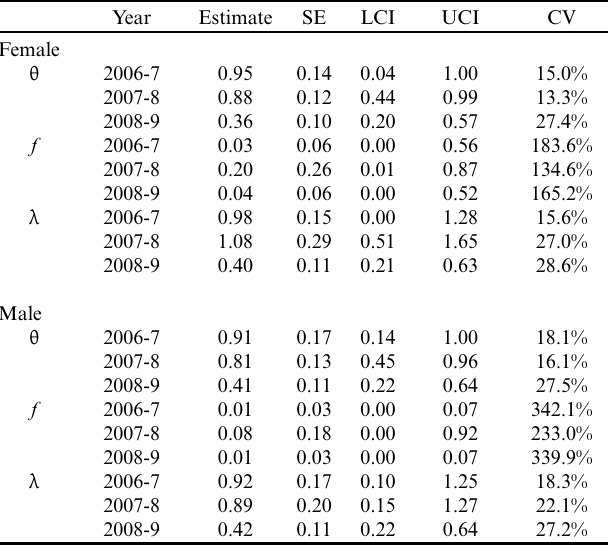
Table 4 . Model averaged demographic parameter estimates for males and females for the Koeye grizzy bear ( Ursus arctos horribilis ) DNA mark-recapture analysis 2006-2009. Estimates of apparent survival ( θ ), rates of addition ( f ), and population rate of change ( λ ) are displayed with lower (LCI) and upper (UCI) 95% confidence limits listed for each. Models used for estimates are listed in Table 2.